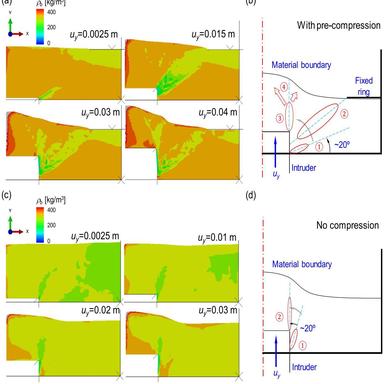
Modeling predicted shear zone development for the case of H = 95 mm and σv = 7.5/0 kPa. (a,c) Bulk density distribution during the intrusion step with and without preconsolidation (σv = 7.5 kPa and σv = 0 kPa, respectively). The shear zones are manifested as local low-density regions. (b,d) Sketch of shear zone migrations for the case with and without pre-consolidation.